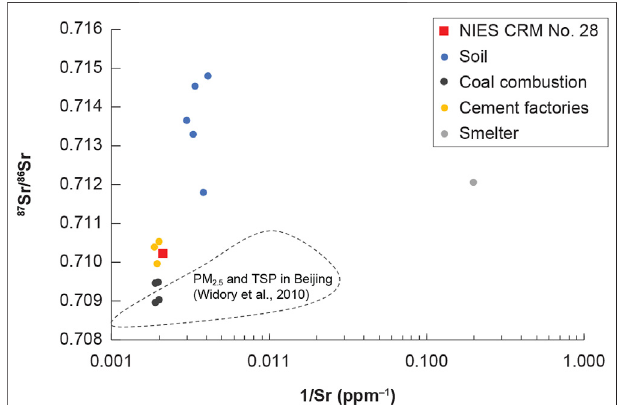
FIGURE 2 | 87 Sr/ 86 Sr ratios vs . Sr concentrations of NIES CRM No. 28 Urban Aerosols and its potential sources. Soils and atmospheric aerosols collected near sources (coal combustions, smelters, and cement factories) in Beijing as reported by Widory et al. (2010) are indicated for comparison. All Sr isotopic data were adjusted to the NIST SRM 987 87 Sr/ 86 Sr value of 0.710248. Note that the x -axis is under a logarithmic